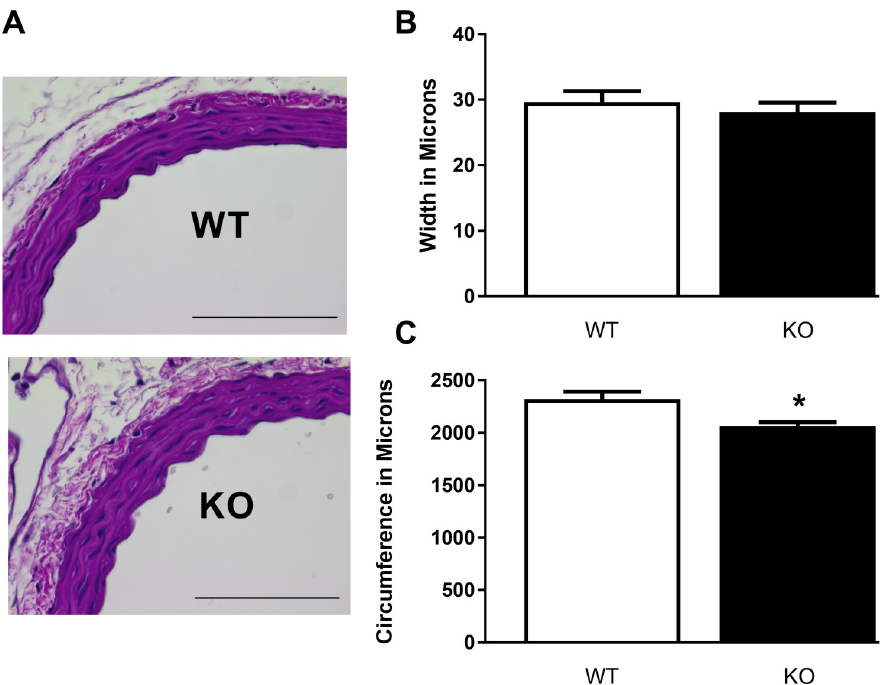
Fig 3. Histological appearance of thoracic aorta in wild-type (WT) and Slc29a1-null (KO) mice. Tissues were gravity perfusion fixed with paraformaldehyde, sectioned in the transverse plane and stained with haematoxylin and eosin. Layers of elastin as well as nuclei arrangement were analyzed (Panel A). Images are representative of six animals of each genotype. Scale bars represent 100 μ m. Panel B shows the vascular wall thickness and lumen circumference derived from these tissue samples (Mean ± SEM, N = 6). � Significant difference in measured parameter between the wild-type and Slc29a1 -null samples (Student’s t-test for unpaired samples, P < 0.05).